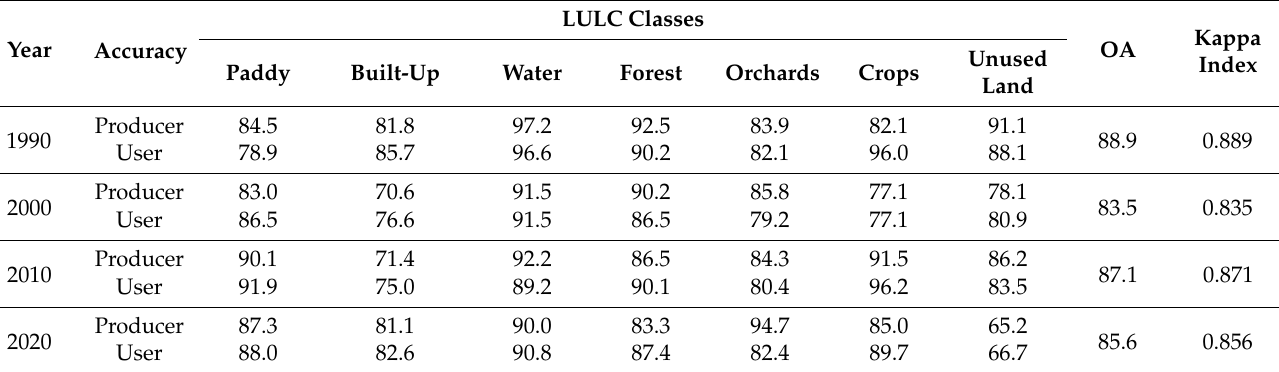
Table 4. Accuracy assessment for the LULC maps of the Dong Thap Muoi area, assessed using the training samples. OA: overall accuracy.